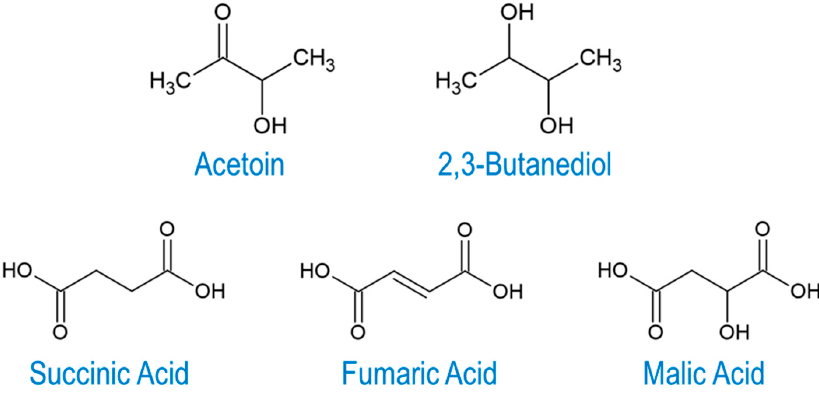
Figure 1. Structural representations of highlighted C4 platform chemicals.